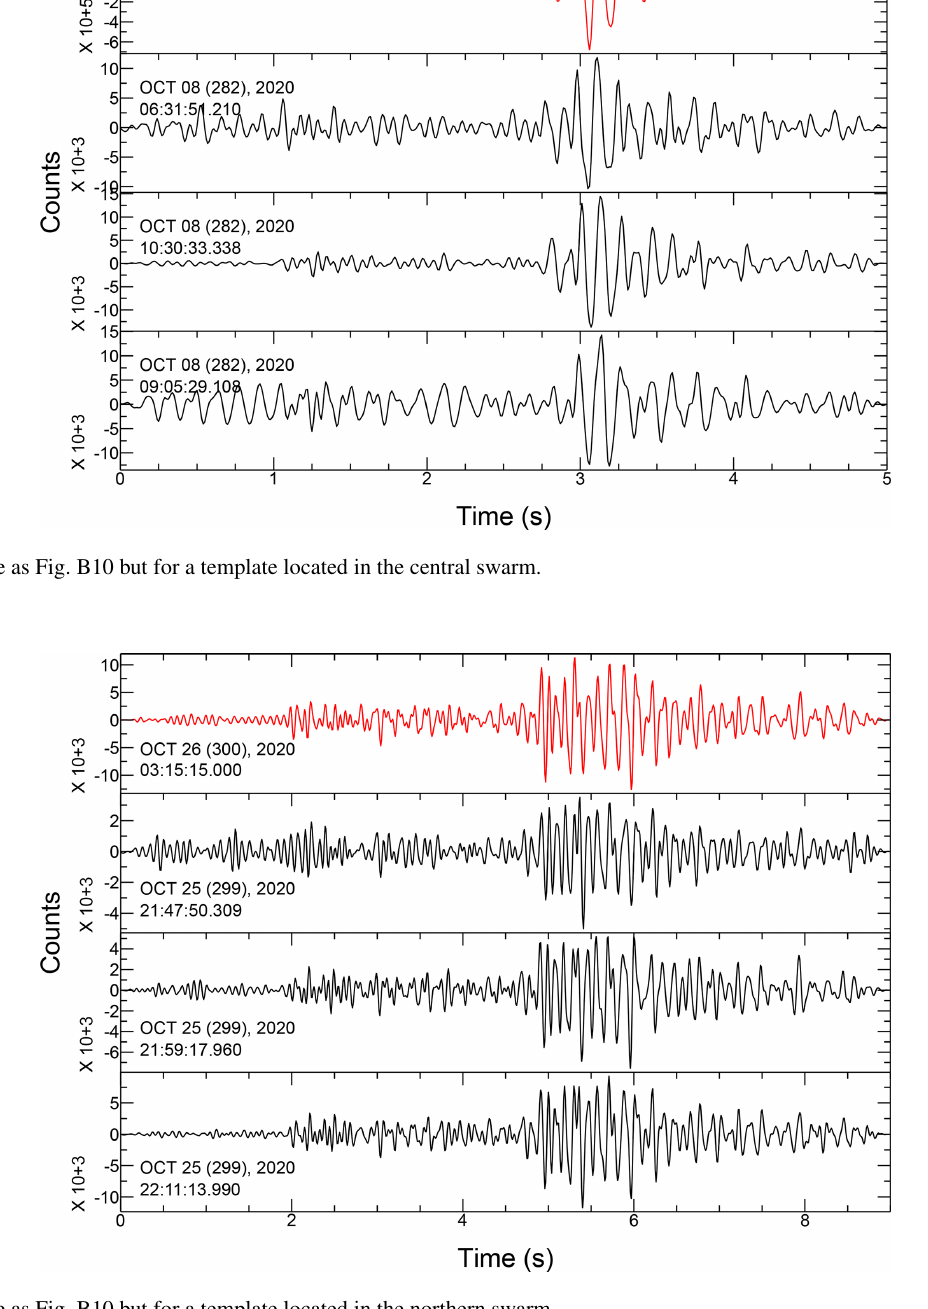
Figure B12. Same as Fig. B10 but for a template located in the northern